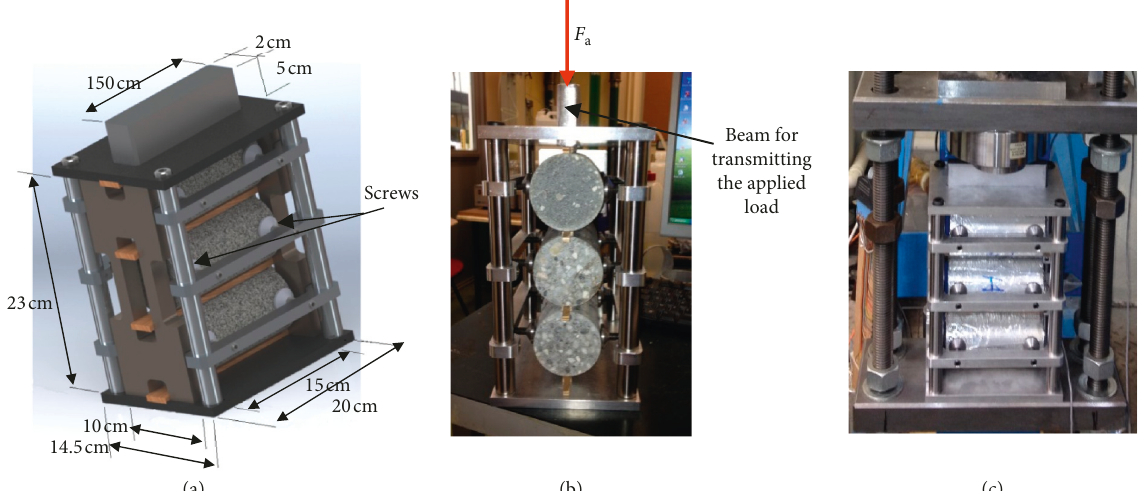
Figure 4: Apparatus specifically developed to hold 3 specimens throughout the indirect tensile creep test: (a) design drawing of the device; (b) front view of the driven specimens; (c) (sealed) specimen placed into the creep framework.